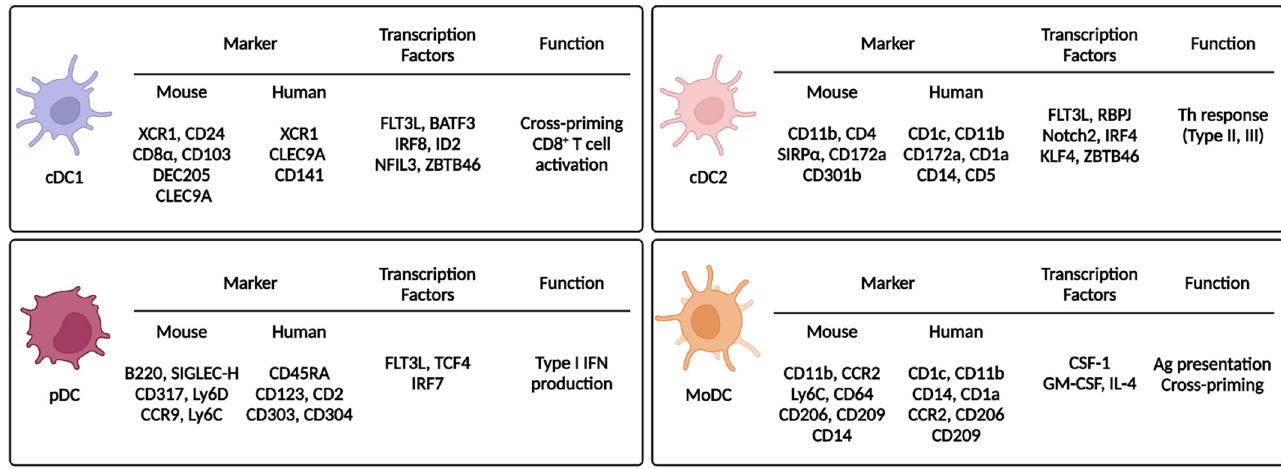
Figure 2. Dendritic cell subsets and their markers, transcription factors, and functions. This figure summarizes the characteristics of the DC subsets. Each DC subset expresses unique markers and transcription factors. XCR1, X-C motif chemokine receptor 1; CLEC9A, C-type lectin domain containing 9A; ID2, inhibitor of DNA binding 2; NFIL3, nuclear factor, interleukin 3 regulated; ZBTB46, zinc finger and BTB domain-containing 46; SIRP α , signal regulatory protein alpha; RBPJ, recombination signal binding protein for immunoglobulin kappa J region; KLF4, Krüppel-like factor 4; TCF4, transcription factor 4; GM-CSF, granulocyte-macrophage colony-stimulating factor; BATF3, basic leucine zipper ATF-like 3 transcription factor; SIGLEC, sialic acid-binding Ig-like lectin; Ly6, lymphocyte antigen 6; CCR, C ‐ C chemokine receptor; IFN, interferon; Th, helper T; Ag, antigen.